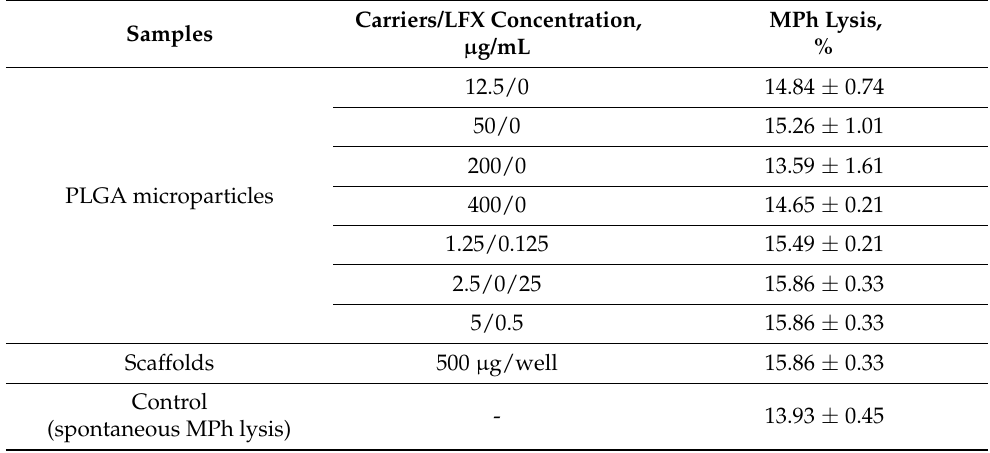
Table 1. Specific lysis of intact macrophages after 1 week of incubation together with the samples.